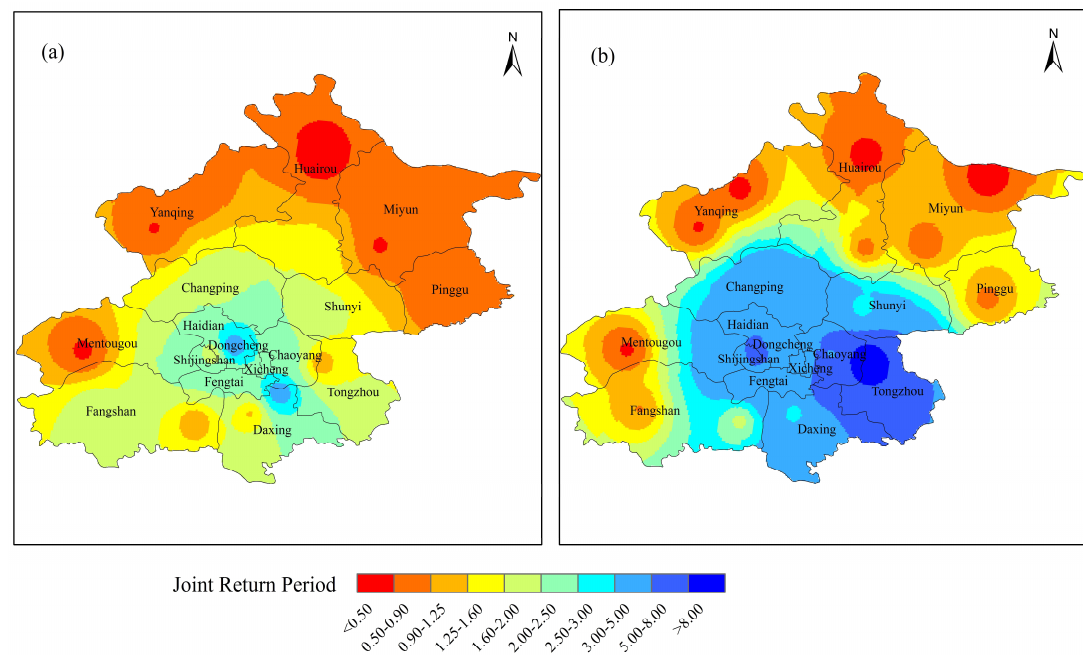
Figure 4. Spatial distributions of joint return periods for low temperature events during study periods: ( a ) 1978–1998; ( b ) 1999–2015 (unit: year).